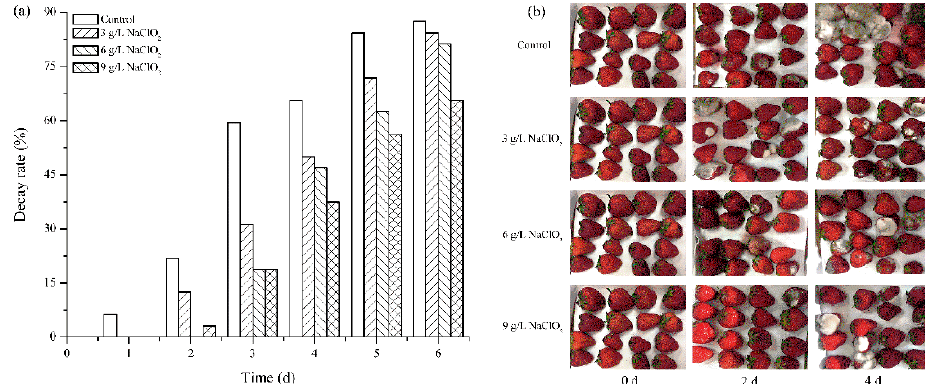
Figure 3. The decay rate ( a ) and appearance ( b ) of strawberries packed in different corrugated cardboard boxes during storage at room temperature.